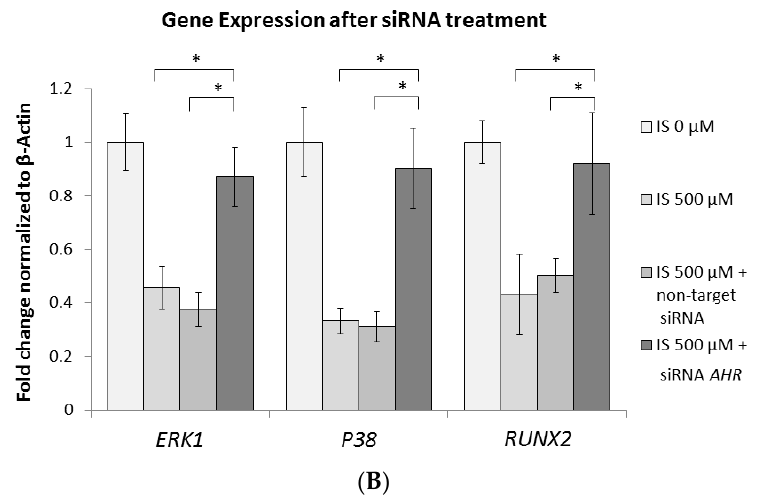
Figure 6. AHR Knockdown results in suppressed CYP1A1 and CYP1B1 gene expression and elevated ERK1, P38, and RUNX2 gene expression. After 1 day of pretreatment with small interfering RNA (siRNA) AHR, or non-target siRNA, MC3T3-E1 cells were cultured in an osteogenesis medium with IS at 0 or 500 µ M for 2 days. ( A ) At 500 µ M IS, the expression of AHR, CYP1A1, and CYP1B1 genes was significantly suppressed in the siRNA AHR group compared with the 500 µ M IS alone and non-target groups. ( B ) At 500 µ M IS, the gene expression of ERK1, P38, and RUNX2 was significantly enhanced in the siRNA AHR group when compared to the 500 µ M IS alone and non-target groups. Data are represented as the mean ± SEM ( n = 3). * Indicates di ff erences that were considered significant between the indicated groups ( p < 0.05).